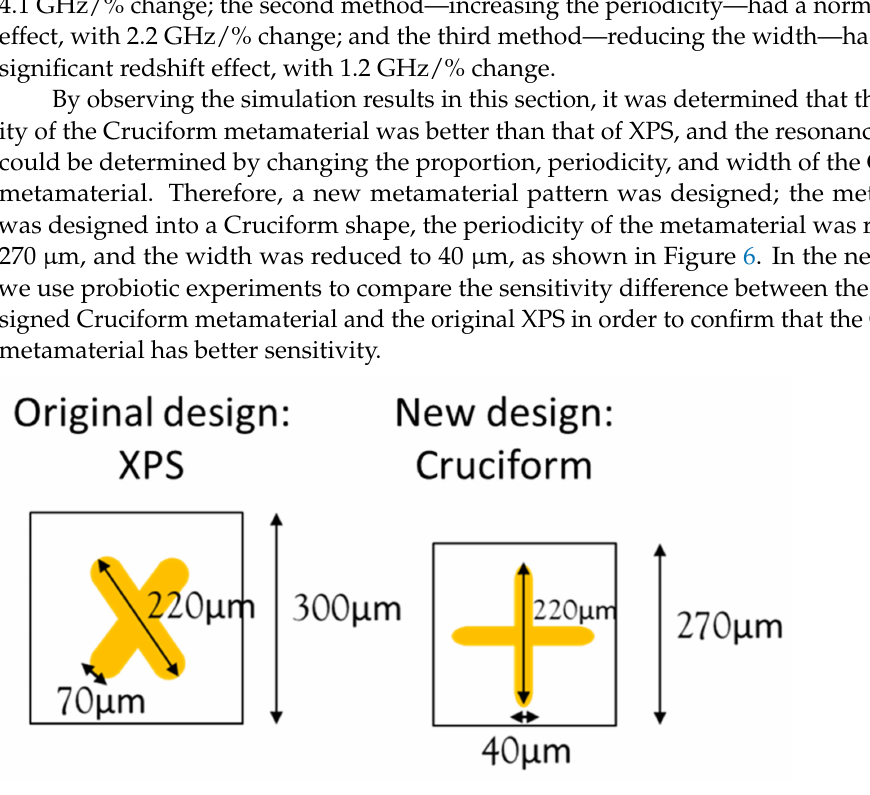
Figure 6. Schematic diagram of original design (XPS) and new design